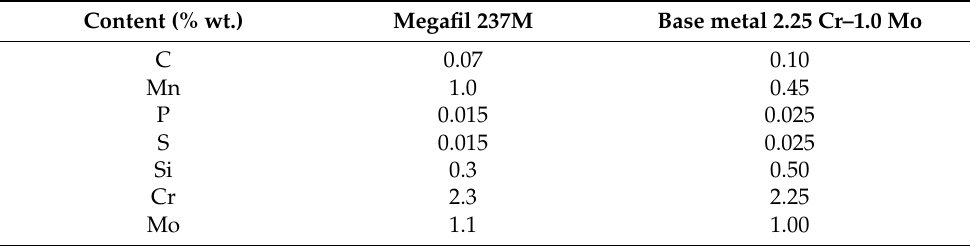
Table 1. Chemical composition of base metal and filler wire